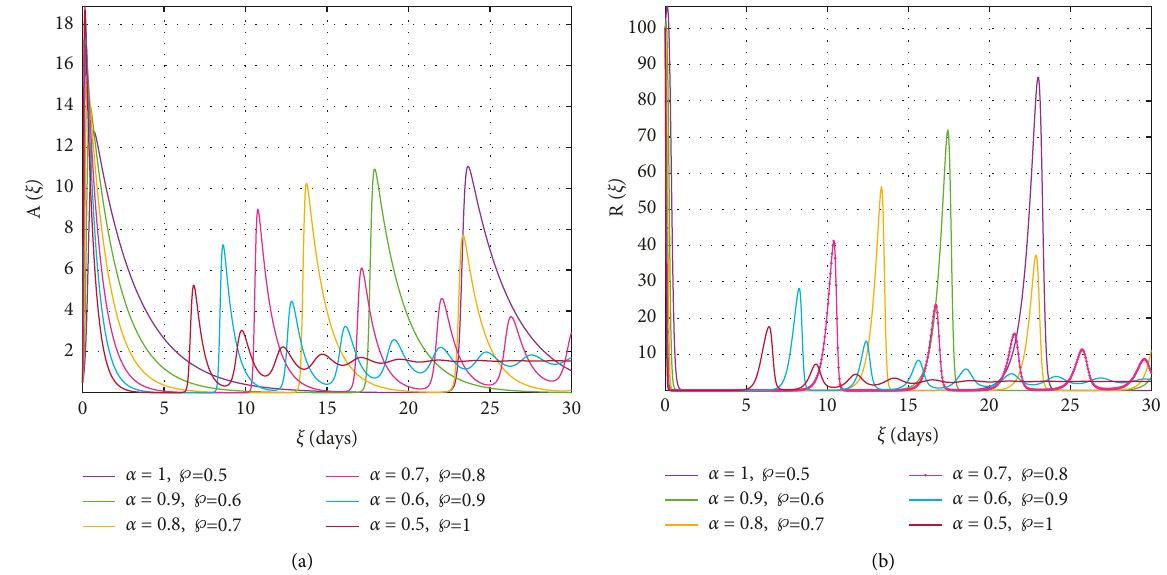
Figure 2: (a) Displays of addicted individuals A ( ζ ) (b) Displays of recovered individuals R ( ζ ) using a Newton polynomial approach for decreasing fractional-order α and increasing fractal-dimension ℘